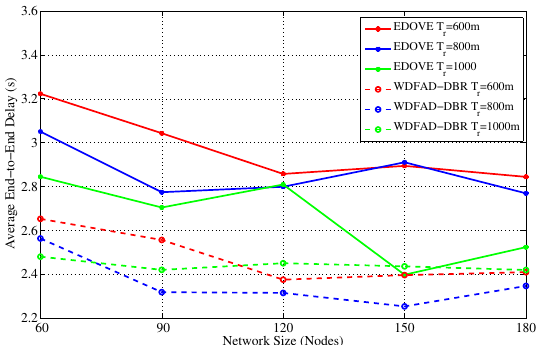
Figure 23. End-to-End delay between Source node that generated data message and Sink node versus the network sizes.